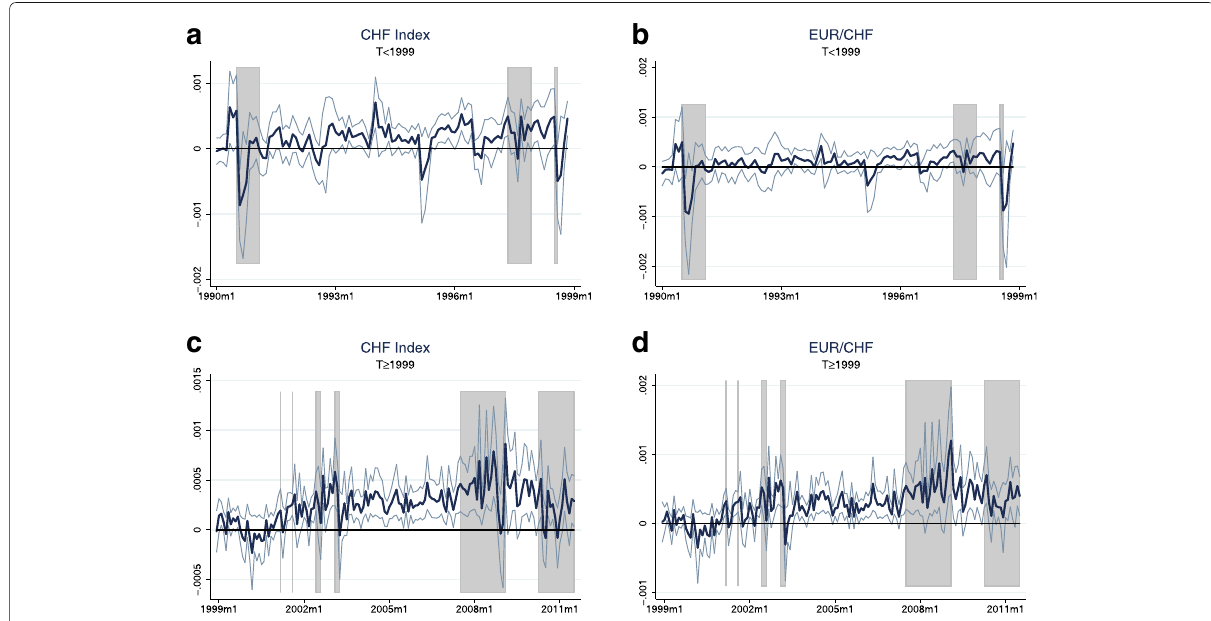
Fig. 6 ( a - d ) Predicted conditional covariance—subsamples. Notes: The estimates of the conditional covariance correspond to the fitted value of the (cid:6) (cid:7) = ˆ α r ω t + 1 , (cid:2) e t + 1 first stage regression: (cid:13) Cov t Z Z t (see Eq. (9)). In this first stage regression, the ex-post covariance obtained from the zero stage regressions is regressed on a set of instruments. The set of instruments Z t consists of a constant, the dividend-price ratio, the lagged equity return, plus a measure for the lagged equity return variance, exchange rate return variance, and their covariance. The zero stage regressions are estimated for each subsample separately. The first subsample (January 1990 to December 1998) consists of 107 observations and the second subsample (January 1999 to August 2011) consists of 152 observations. The two thin lines represent the 95% confidence band and are based on a two